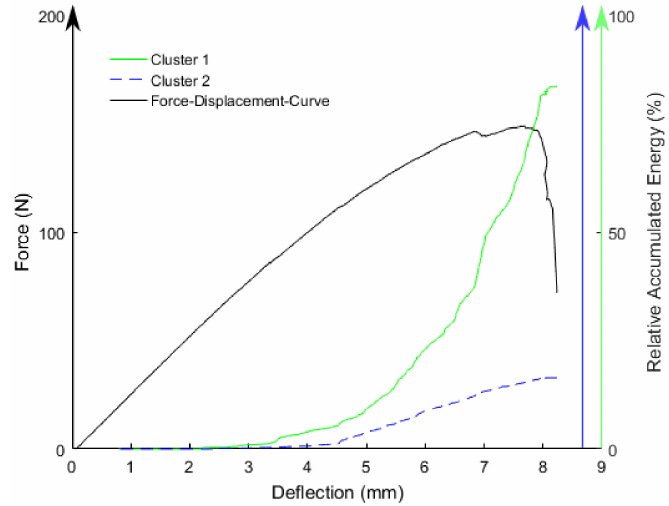
Figure 10. Relative accumulated energy of cluster one and cluster two and the force-deflection response.